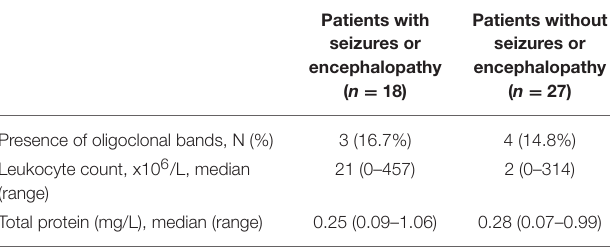
Patients with Patients without seizures or seizures or encephalopathy encephalopathy ( n = 18) ( n = 27)